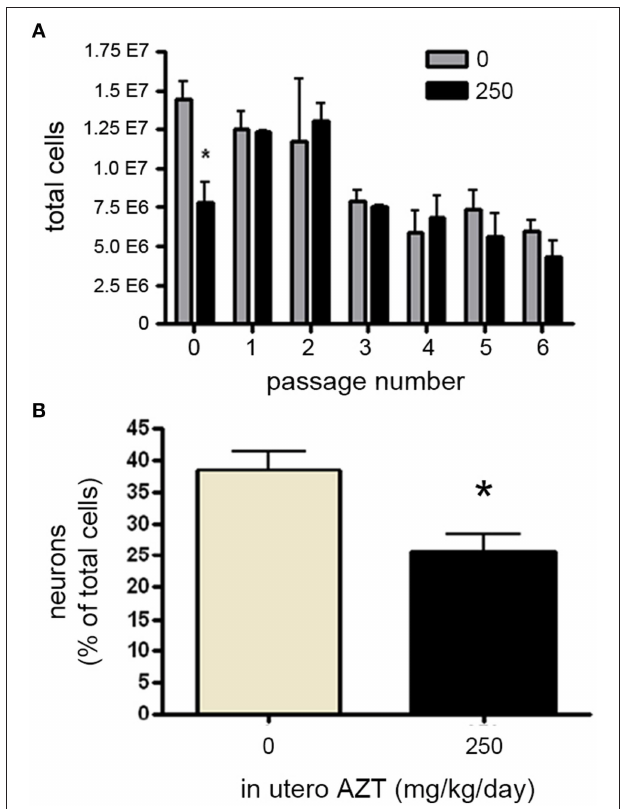
FIGURE 8 | In utero AZT perturbs MASC proliferation and differentiation. AZT was administered to pregnant dams from day 12 of gestation until postnatal day 3 (250mg/kg/day, s.q.). At postnatal day 3 primary MASC were generated from the SEZ of the pups. The MASC were assayed for inducible neurogenesis at passage 1, and were assayed for population expansion over 6 passages. (A) In utero AZT administration also decreases the expansion potential of primary MASC, but this deficit is not maintained over 6 passages as control and treated MASC equilibrate in population expansion after passaging. (B) Inducible neurogenesis in MASC cultures derived from pups exposed to AZT in utero is reduced by approximately 35% compared to age-matched pups born to untreated mothers. Unpaired Student’s t -test; N = 3 for all groups; ∗ p < 0 . 05 .Error bars represent standard deviation.